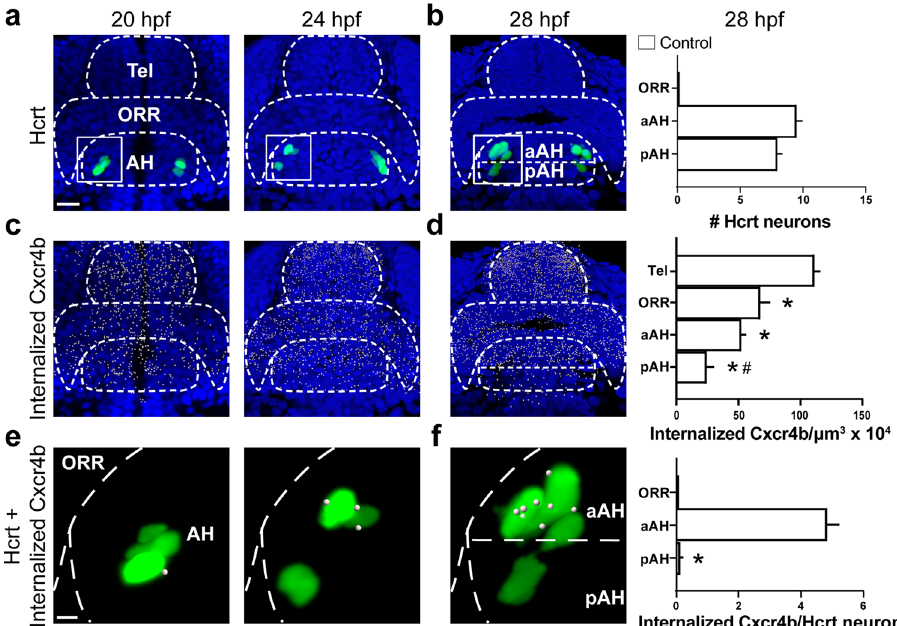
Figure 5. Embryonic development of Hcrt neurons and internalized Cxcr4b under control conditions in 20, 24 and 28 hpf zebrafish brains, as evidenced by immunofluorescence histochemistry. ( a ) Representative photomicrographs (×25) illustrate the zebrafish brain in a dorsal/ventral view with the pAH, aAH, ORR and Tel of the brain outlined by dashed lines, the Hcrt neurons (green) shown tightly clustered together at 20 hpf while spreading out and increasing in number at 24 hpf, and the cells counterstained with DAPI (blue). ( b ) Hcrt neurons become more spread apart at 28 hpf, with an equal number of Hcrt neurons detected in the aAH and the pAH and no Hcrt neurons detected in the ORR, as shown in the bar graph (n = 4). ( c ) Representative photomicrographs show the density of internalized Cxcr4b receptors (white, indicated by digital “spots”) naturally increases from 20 to 24 hpf, and they show a tendency to increase from the AH to the Tel part of the brain. ( d ) Representative photomicrographs show the internalized Cxcr4b receptors at 28 hpf become more dense and exhibit a natural posterior-to-anterior concentration gradient throughout the brain, with lowest levels in the pAH, moderate levels in the aAH and ORR, and highest levels in the Tel, as shown in the bar graphs (n = 4). ( e ) Enlargements of boxes at 20 hpf show no Hcrt neurons with internalized Cxcr4b receptors, while internalized Cxcr4b receptors within Hcrt neurons become apparent at 24 hpf. ( f ) Enlargement of boxes at 28 hpf show an increase in the number of internalized Cxcr4b receptors in Hcrt neurons, with Hcrt neurons located in the aAH showing a greater number than the pAH of these internalized Cxcr4b receptors, as shown in the bar graphs (n = 4). Scale bar: low magnification 20 µm; high magnification 8 µm. * p < 0.05 and # p < 0.05 compared to Tel and aAH respectively. Results are shown as means ± standard errors. AH anterior hypothalamus, aAH anterior part of the anterior hypothalamus, pAH posterior part of the anterior hypothalamus, ORR optic recess region, Tel telencephalon, Hcrt hypocretin, hpf hours post